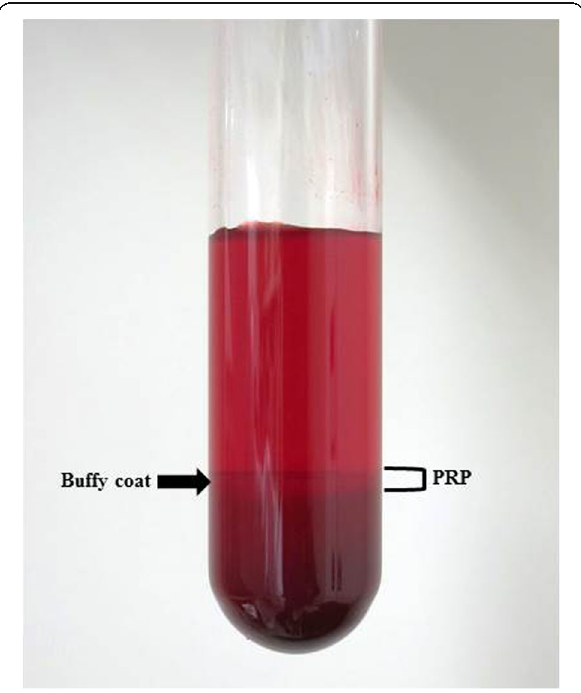
Fig. 2 Whole blood in a tube containing ACD, which was anticoagulant, after centrifuging shows 3 layers comprising clear plasma, buffy coat including PRP component, and RBC